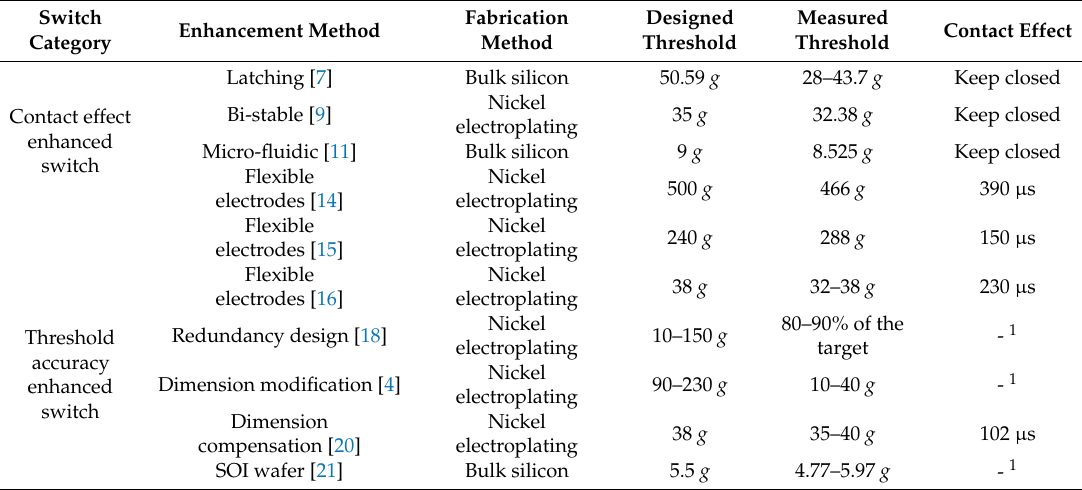
Table 1. Comparisons of the main research results reported in the